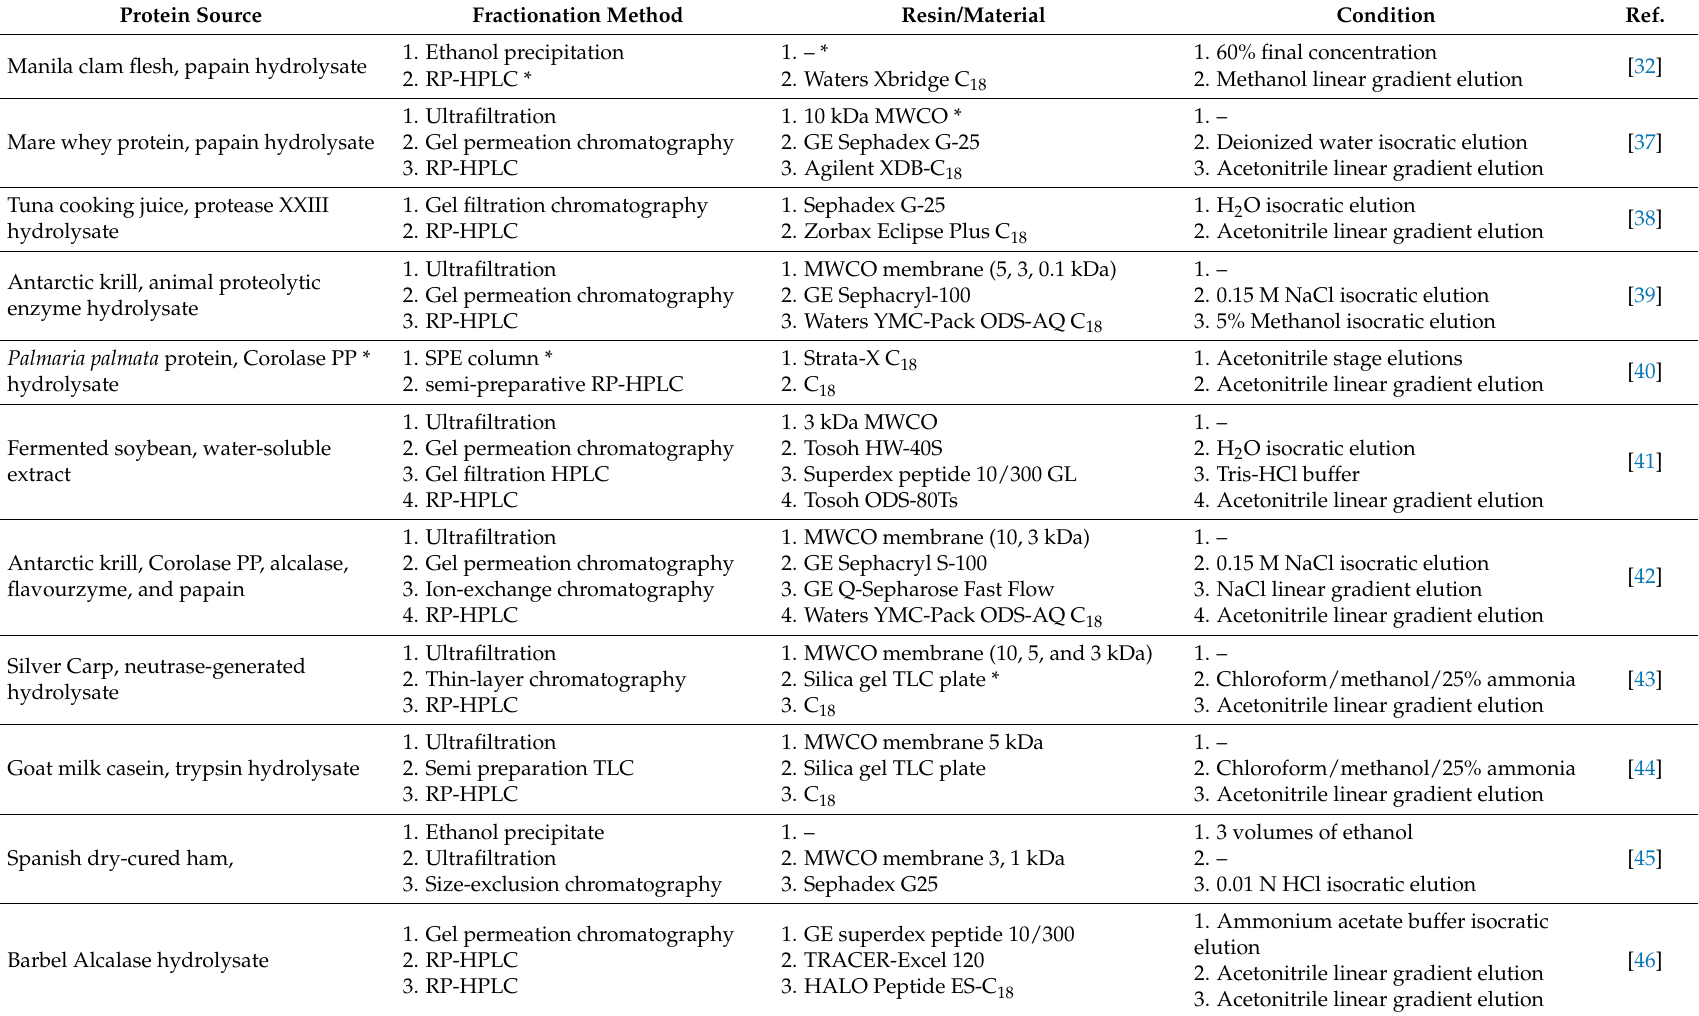
Table 1. Recently reported examples of methods on DPP-IV inhibitory peptides fractionation and